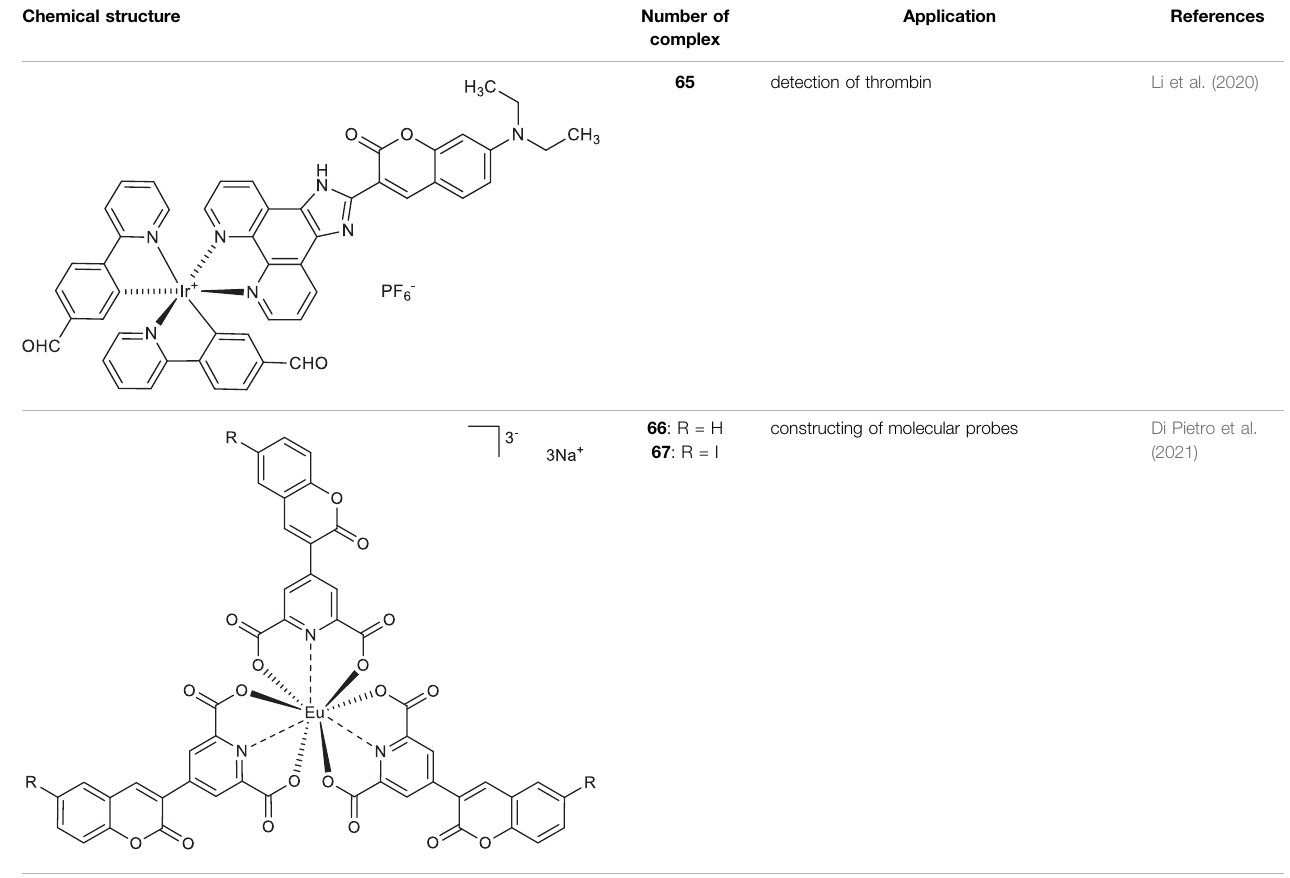
( Table 1 ) complexes with coumarin-derived Schiff base ligand